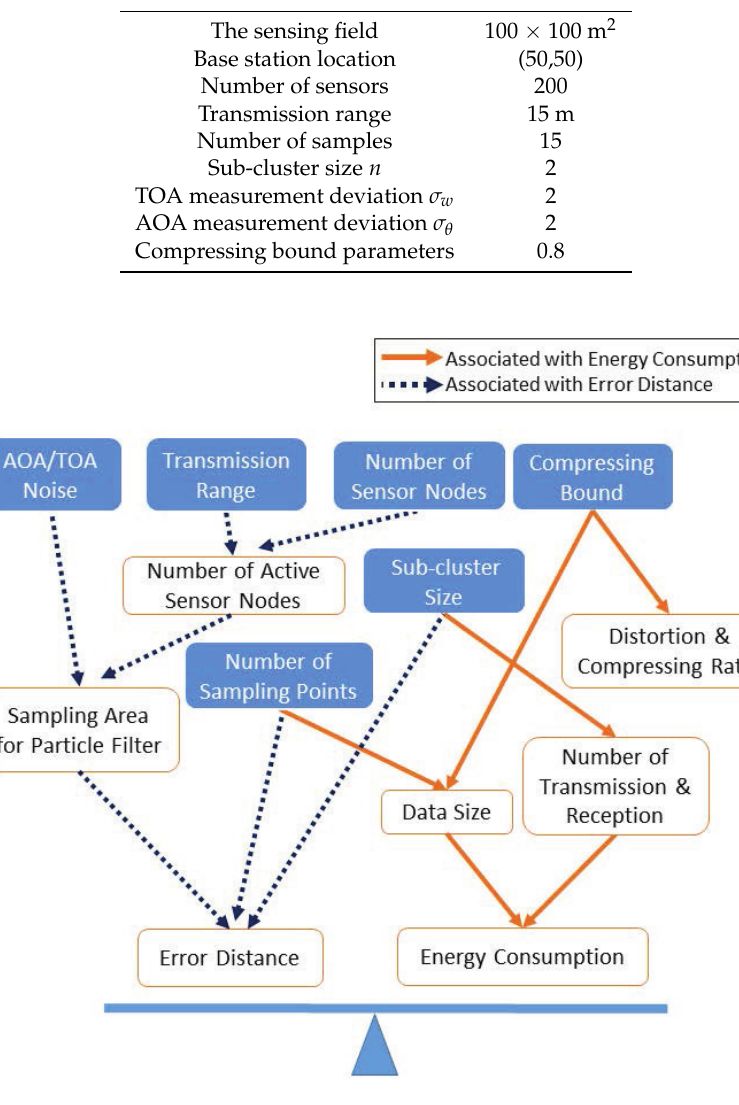
Figure 13. The impacts of system parameters on the tracking performance from two perspectives: (1) distance estimation and (2) energy